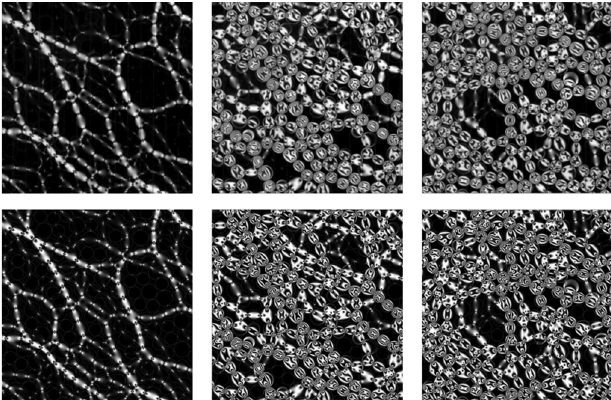
through a polariscope (top row) and the reconstructed images based on contact force solutions (bottom row) for three example packings. The visual match between the photoelastic patterns is an evidence of finding the global minimum of the error function [37,38,74]. The pressure of the packing from left to right is 6.8, 42.4, and 53 . 8 N = m.